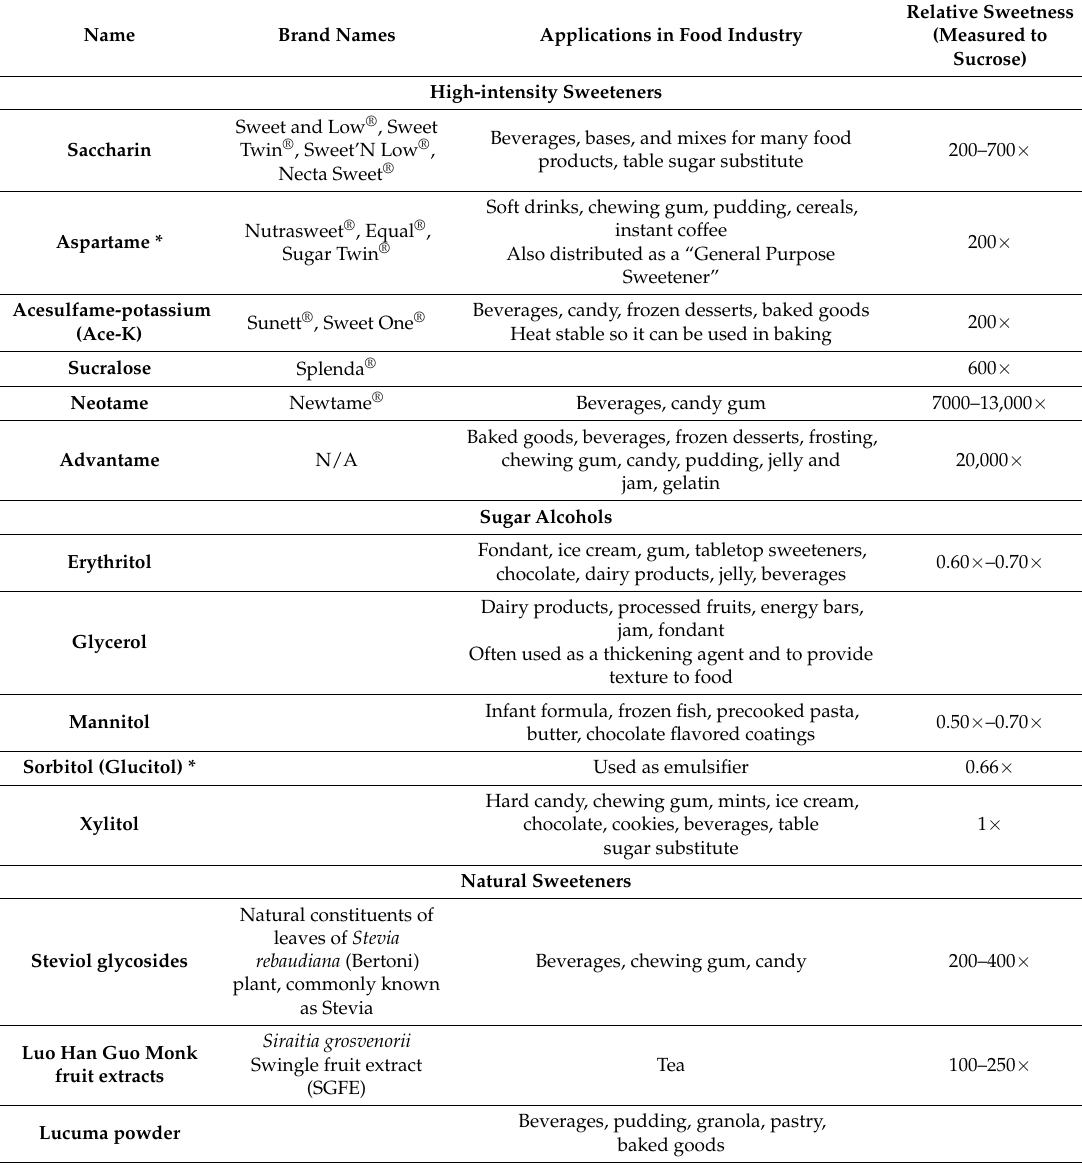
Table 1. Classification of Food and Drug Administration (FDA)-approved